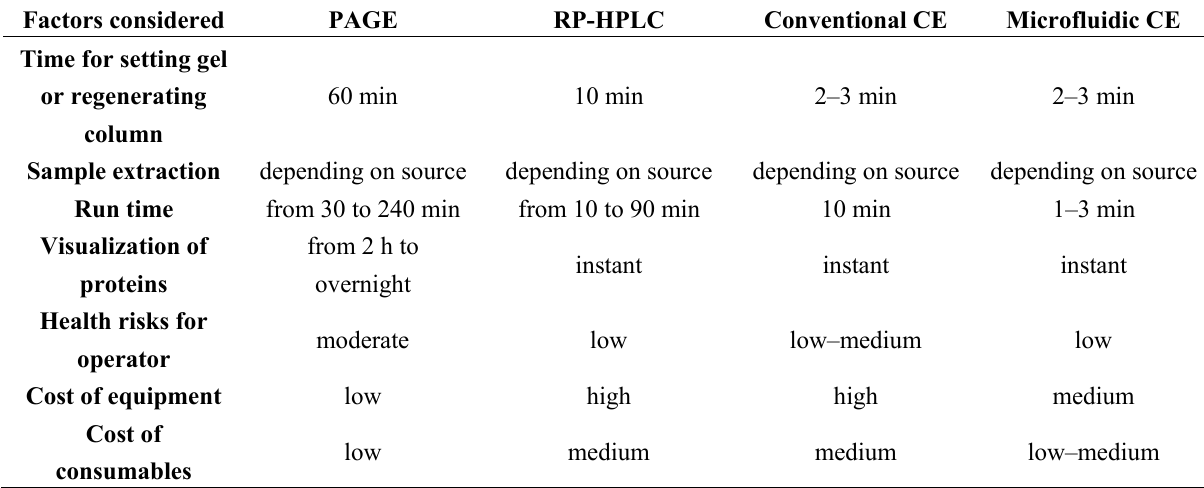
Table 1. Comparison of some routine methods of food protein analysis. Adapted from [18]. Factors